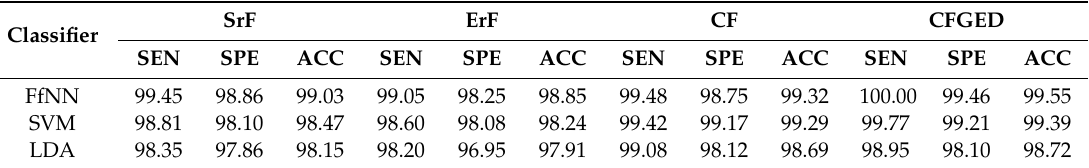
Table 3. Comparative performance in terms of average sensitivity (SEN), specificity (SPE), and classification accuracy(ACC)measuredinpercentage(%)overallninecaseswithdifferentgroupsoffeaturesandclassifiers. SrF, spike-related features; ErF, entropy related features; CF, combined features; CFGED, combined features with graph eigen decomposition; FfNN, feedforward neural network; SVM, support vector machine; LDA, linear discriminant